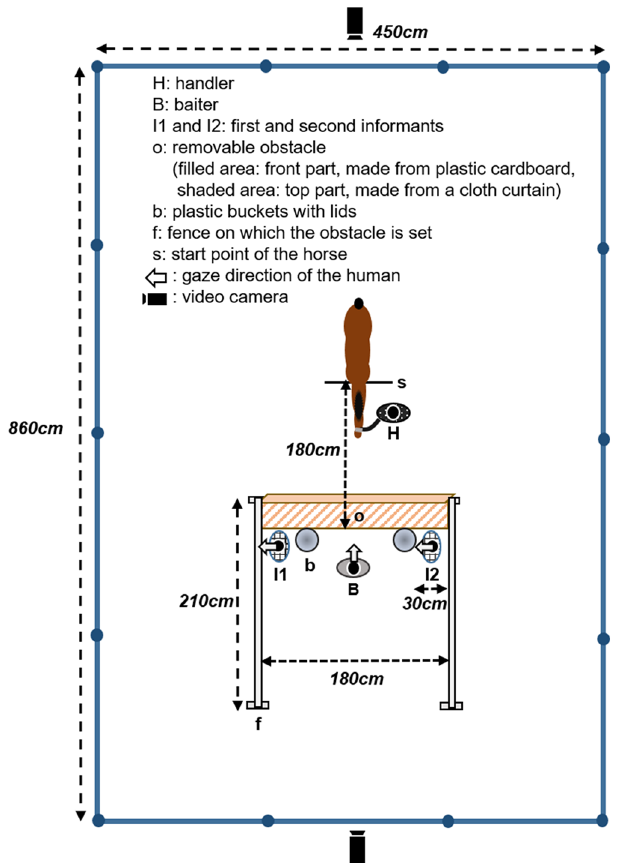
Figure 2. Experimental set-up of the fenced area within a paddock at the beginning of the test trial. Overview of the experimental set-up at the beginning of the test trial. Here, I1 acts as a guesser and I2 acts as a